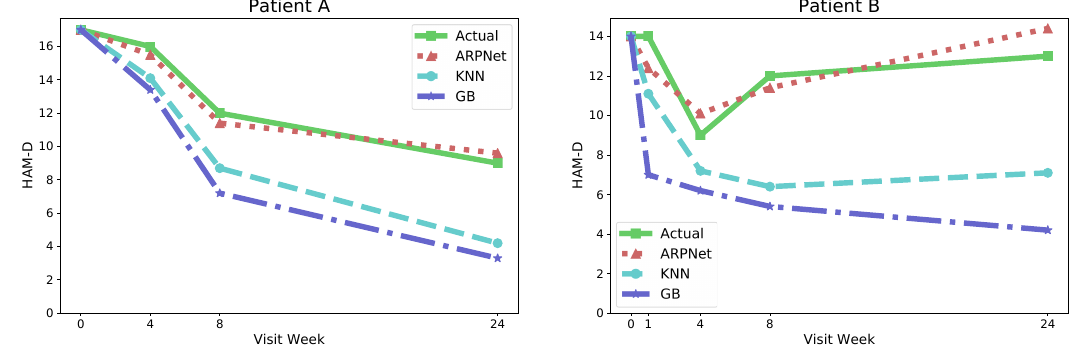
Figure 2. Examples of predicting the clinical remission of patients. KNN and GB denote the K-Nearst Neighbors and Gradient Boosting Regressors,